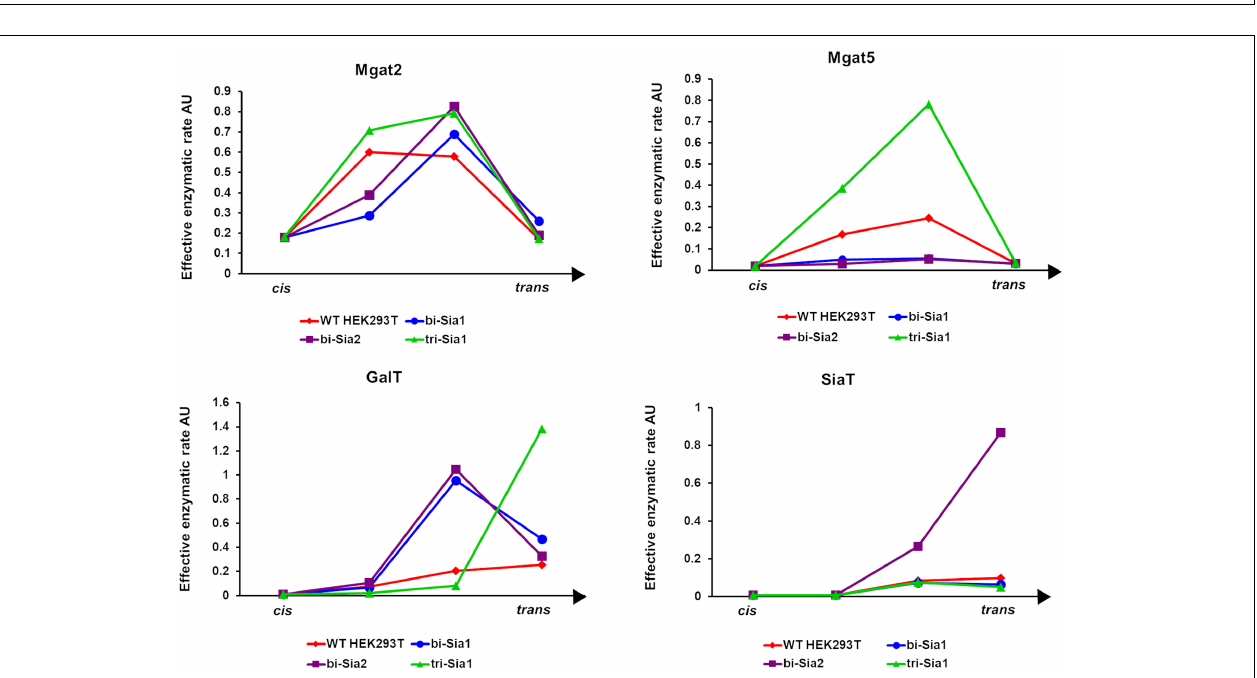
FIGURE 3 | Glycan by-products of maximizing target complex glycans. Relative abundance of the oligomannose pool and the three most abundant complex glycans that are predicted as by-products when maximising the abundance of the indicated target glycans with the indicated type (fixed or variable enzyme localization) of fitting strategy.